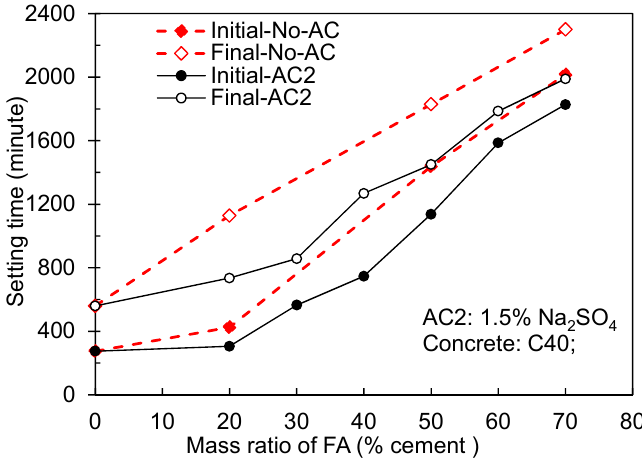
Figure 5. Effect of the mass of FA on setting time.